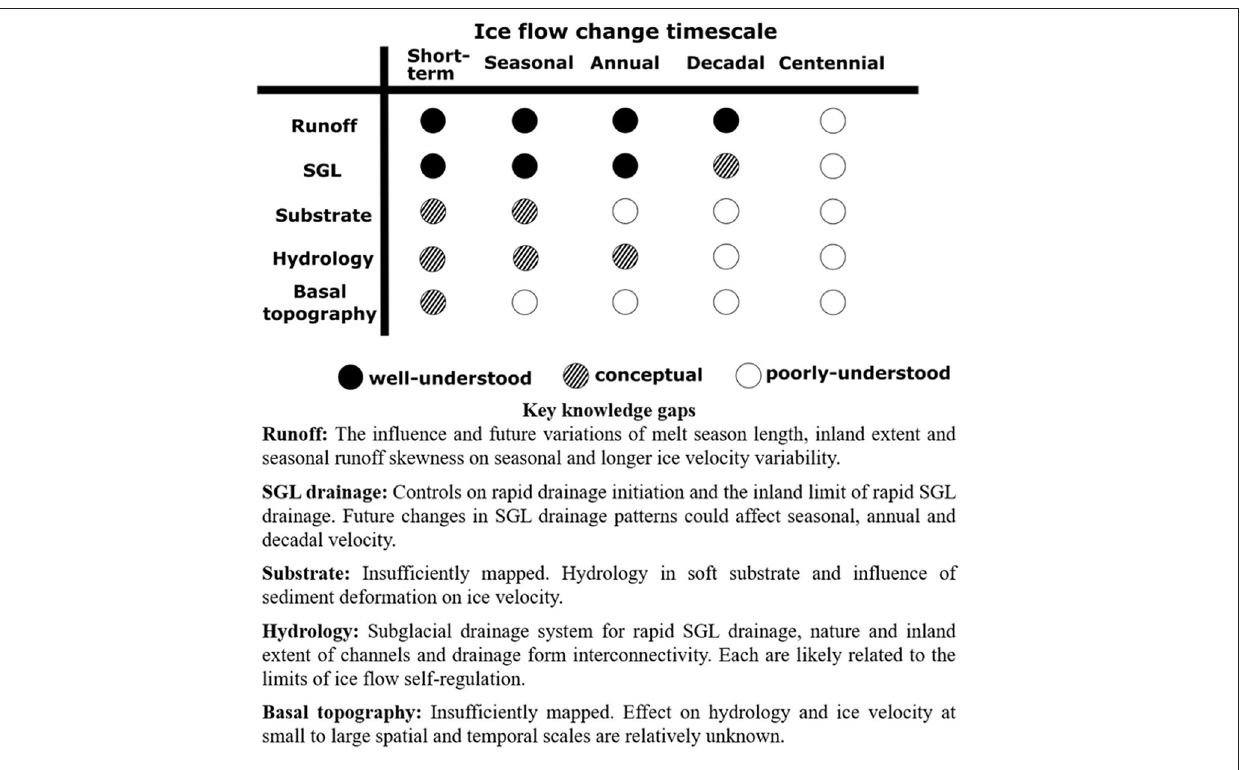
FIGURE 9 | Summary of current understanding of the influence of system components on ice flow variations. Note, that although the processes discussed in the main text may be applicable at the centennial time scale, they are not usually incorporated into model simulations of Greenland Ice Sheet dynamics at this time